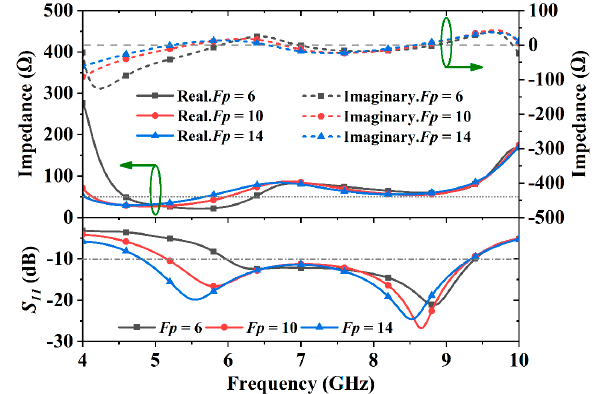
Figure 4. The impedance and S 11 for different values of Fp.